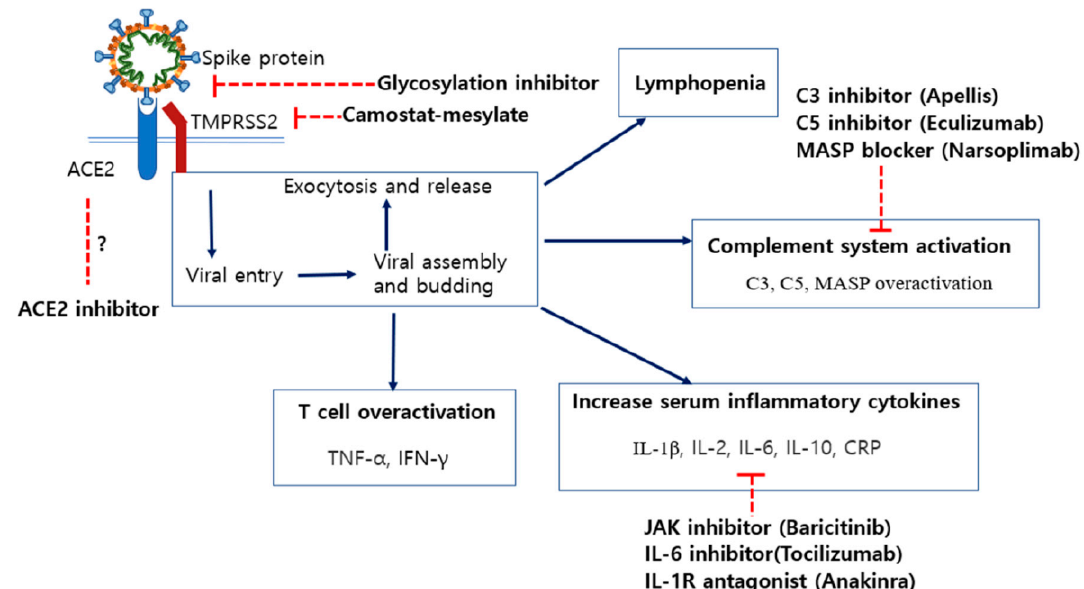
Figure 7. Possible treatment strategies for COVID-19 patients that block receptor recognition or inhibit immune reactions. Spike protein cleavage is essential for ACE2 recognition. The synthetic serine protease inhibitor, camostat–mesilate, seems to block viral entry by inhibiting the activity of TMPRSS2. Additionally, several glycosylation sites of the spike protein could be targets to lower the affinity of the spike protein for ACE2. Thus, specific glycosylation inhibitors could be an option for COVID-19 treatment. Severe inflammation causes pneumonia, critical tissue injury, or even cytokine storms in COVID-19 patients. Therefore, proven immunomodulators, including the JAK inhibitor baricitinib, the IL-6 inhibitor tocilizumab, or the IL-1R antagonist anakinra, could be beneficial treatments. Additionally, complement system inhibitors are expected to alleviate inflammation and overactivation of immune cells. Several clinical trials are ongoing and further study is needed to ensure their efficacy and